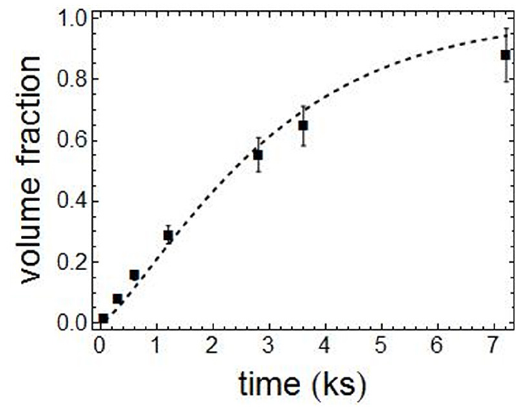
Figure 2. Comparison between model (dashed line), Equation 4, and theoretical volume fraction (filled squares) obtained from experimental data of γ -fiber orientations by Equation 2.